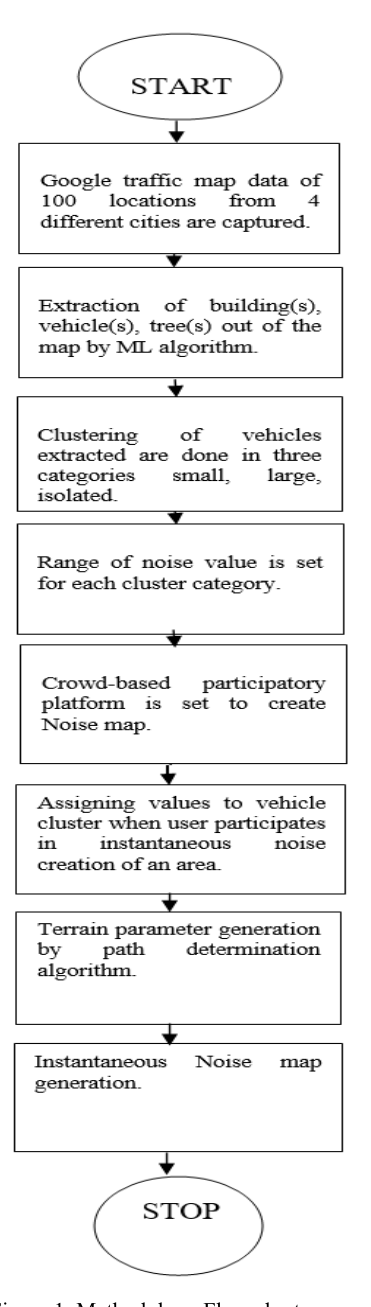
Figure 1. Methodology Flow